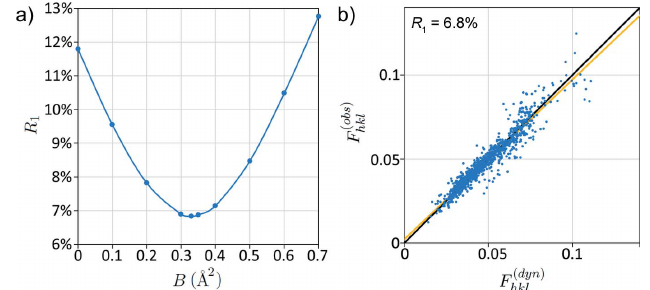
Figure 11 ( a ) R 1 as a function of Debye–Waller factor B . ( b ) Optimized R 1 calculation for B = 0.33, giving a best R 1 = 6.8% at a specimen thickness of 185